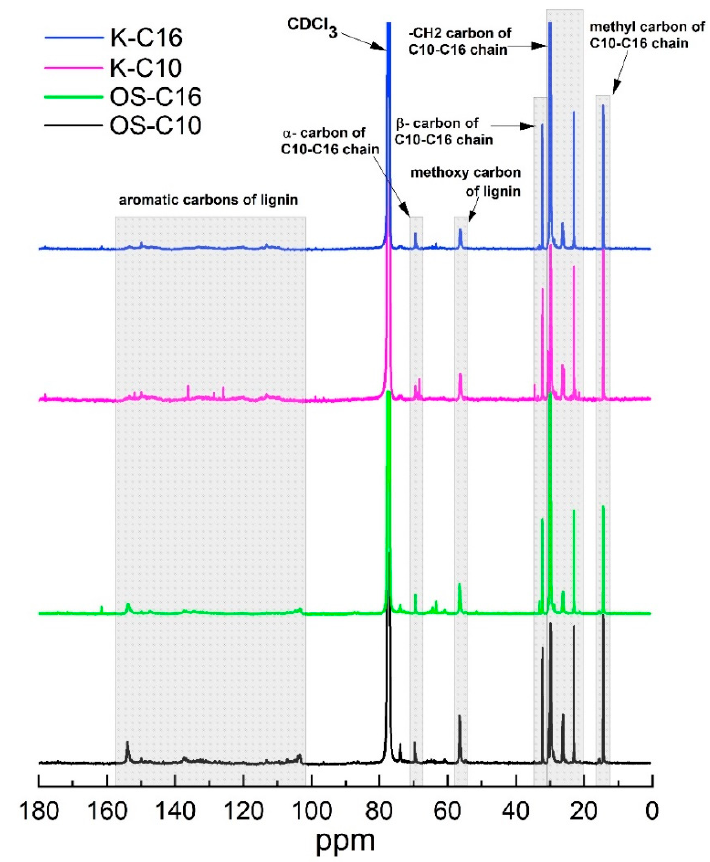
Figure 4. 13 C NMR spectra of functionalized organosolv (OS) and Kraft (K) lignins. Table 3. Molecular weight values for non-functionalized organosolv (OS) and Kraft (K) lignin, as well as for their derivatives after